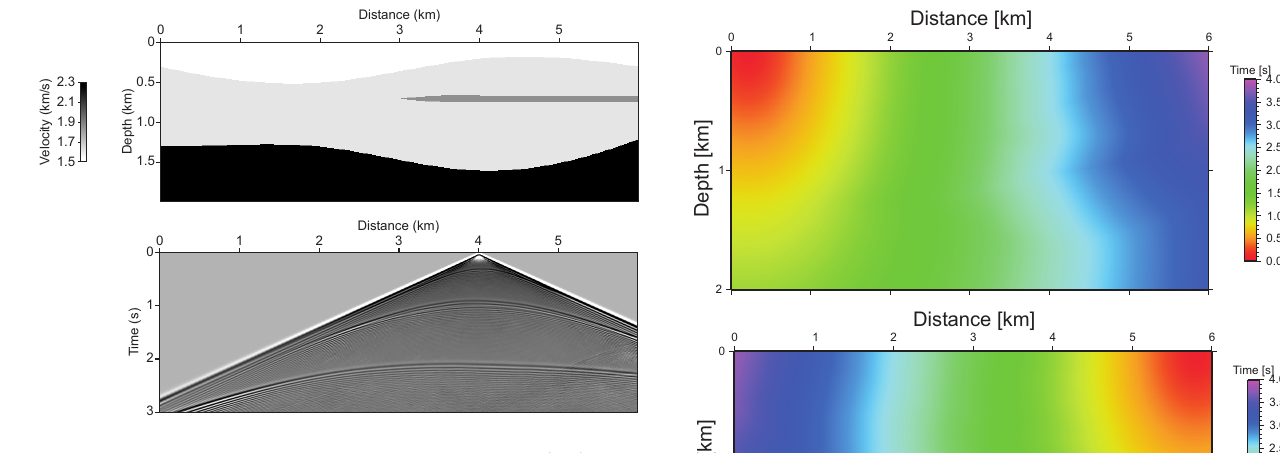
Figure 3. Migrated image of the synthetic example.